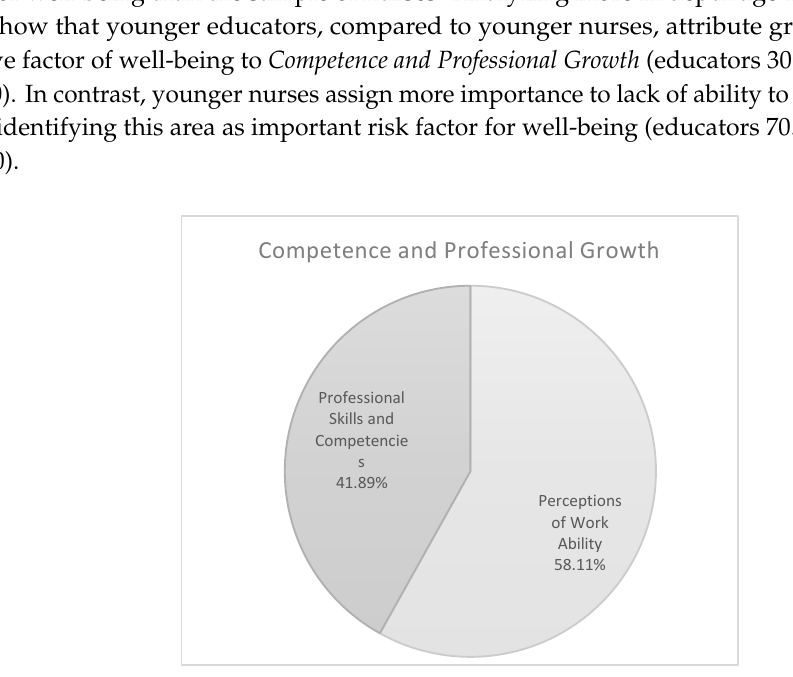
Table 2. Risk and protective factors of well-being at work: data comparison between educators and nurses.